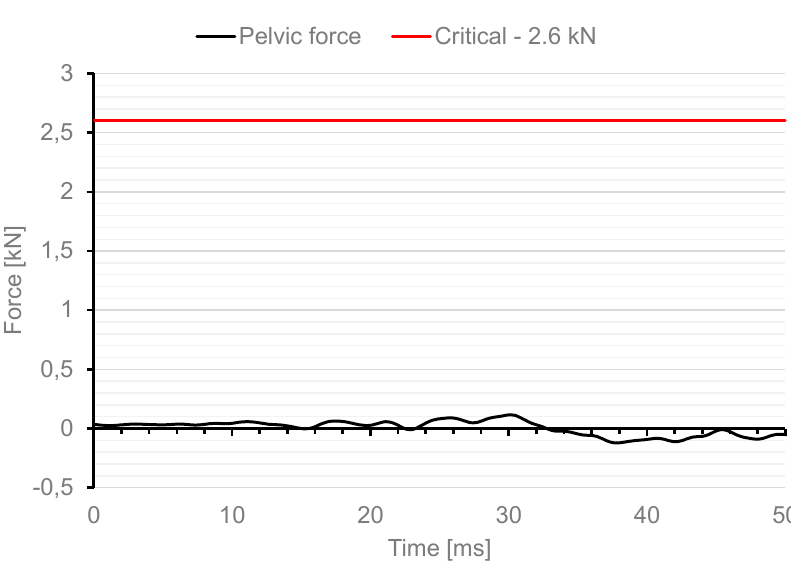
Figure 14. Characteristics of force change in a dummy pelvis after blast with use of 15 kg TNT charge.